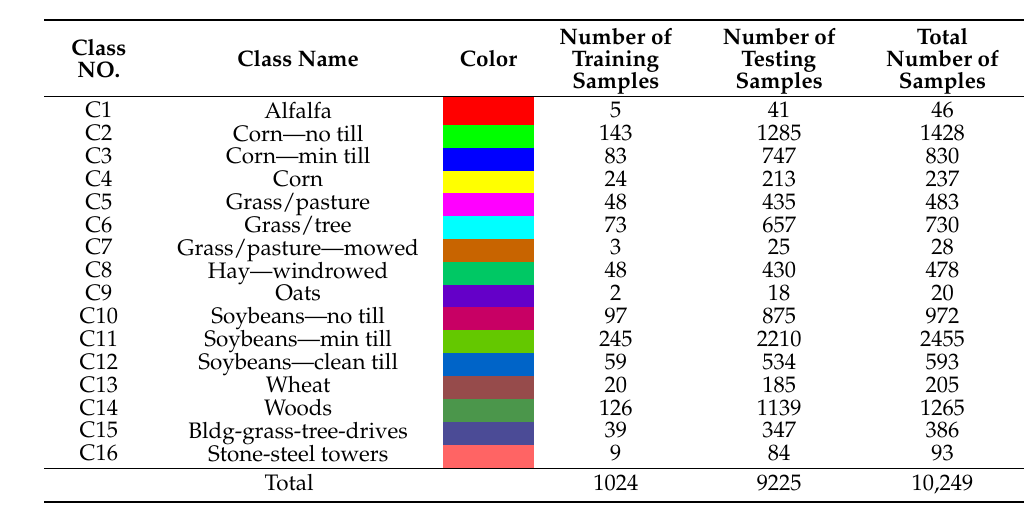
Figure 7. Classification maps for the IP dataset with 10% of training data. ( a ) False-color image, ( b ) Ground-truth map, ( c ) CNN1D, ( d ) CNN2D, ( e ) CNN3D, ( f ) SSUN, ( g ) HybridSN, ( h ) Bi-LSTM-CNN. Table 1. Details of the IP dataset.